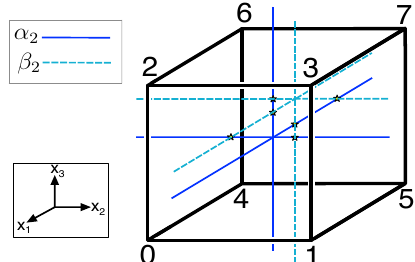
Figure 42: The cup-1 product of α and β is determined by the intersections (labeled 2 2 by stars) of their dual edges, after the projection from a certain angle. There are six intersections of the dual edges, which gives the six terms in the definition of the cup- 1 product Eq.